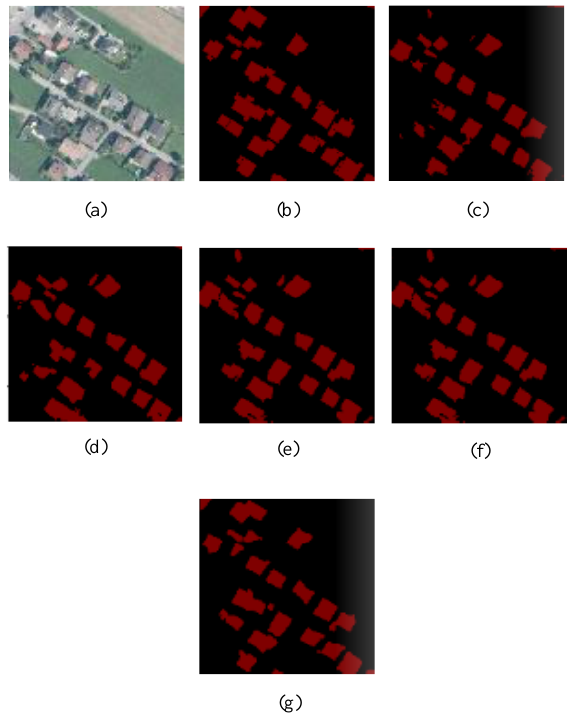
Figure 10. Comparison results results of semantic segmentation methods. ( a ) Input Image ( b ) Ground Truth; ( c ) ResNet50 + ASPP; ( d ) DeepLabV3+; ( e ) ENet; ( f ) ESPNet; ( g ) Our method (LResNet50 + WASP(AVE) + GFG).